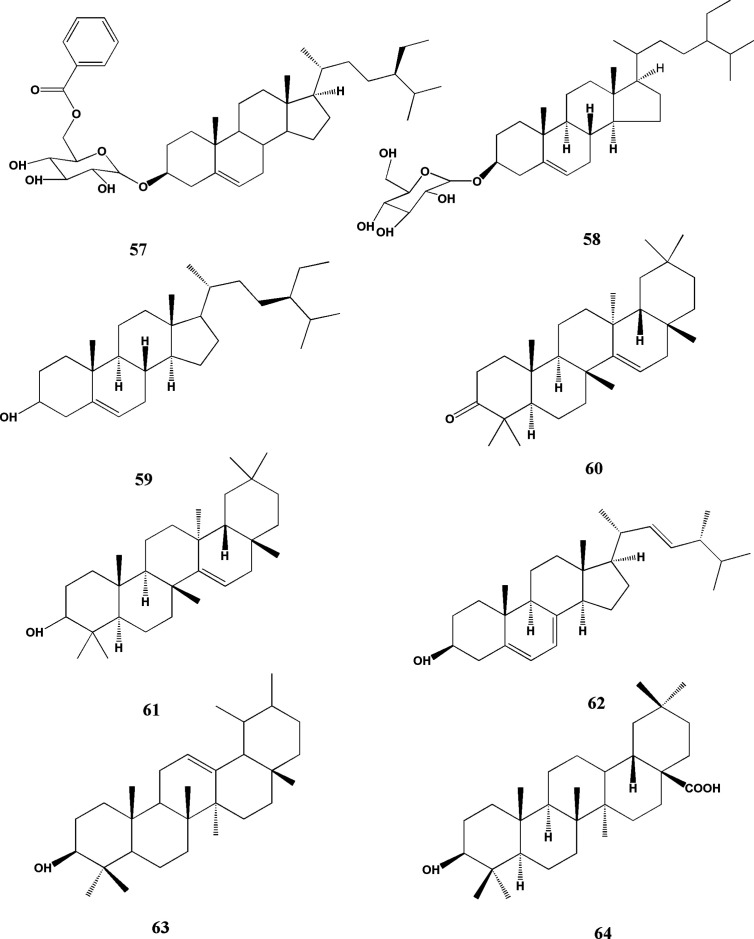
Structures of triterpenoids and steroids from Tetrastigma hemsleyanum Diels & Gilg.